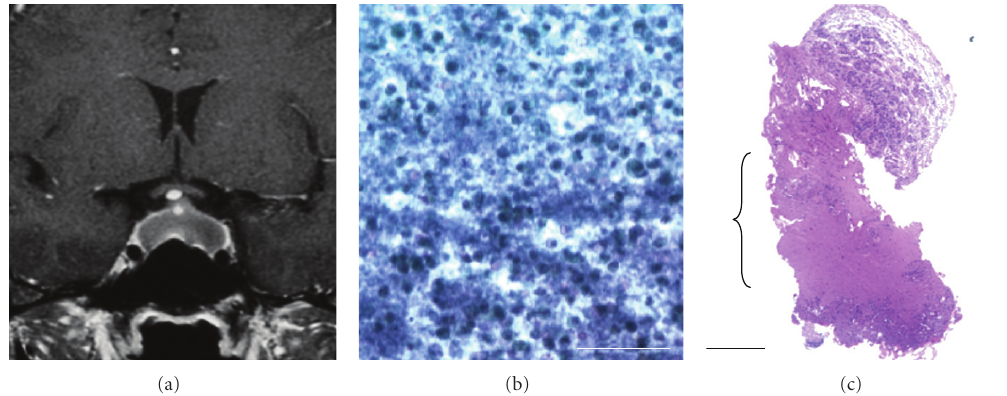
Figure 2: (a) Preoperative coronal contrast-enhanced T1-weighted MRI demonstrating a ring-enhanced mass in the sella. (b) A photomicrograph of aspiration cytology of the pus obtained during the surgery in case 2, demonstrating a cluster of neutrophils: Papanicolaou stain, scale bar; 100 µ m. (c) A photomicrograph of a histological cross section from the capsule of the abscess. The capsule of the abscess was the collagen-rich layer (parenthesis). Ciliated columnar epithelium indicating Rathke cleft cyst was not present in any specimens obtained during surgery: H and E staining, scale bar; 200 µ